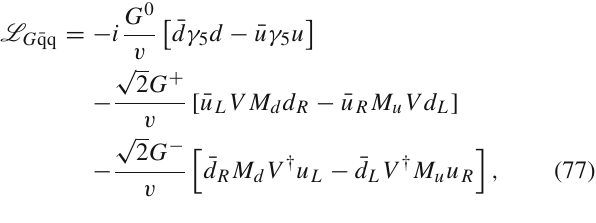
(c) M Max vs. M Min . ( d ) tan β vs. | sin 2 θ |